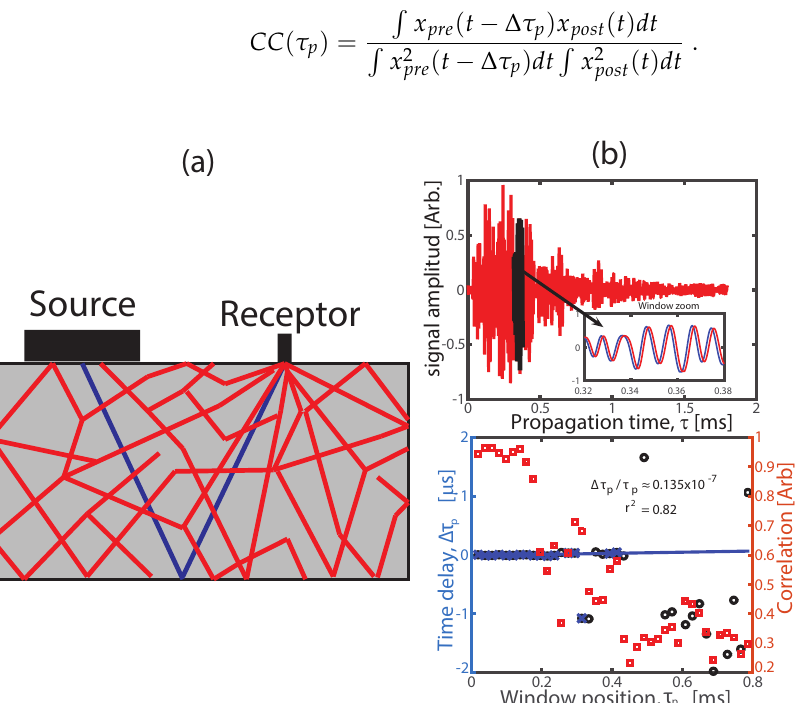
Figure 2. CWI technique. ( a ) Schematic diagram showing the principle of the CWI technique with a coda wave source and a small receptor. The coherent pulse is shown in blue while the diffuse waves are shown in red. ( b ) Sound speed estimation by fitting the filtered curve ∆ τ p against τ p (blue). In Figure 2b above, two consecutive coda signals are shown and in the inset it is highlighted the time-shift of a specific window (black). In Figure 2b below it is shown the ∆ τ p against τ p (blue and black) and CC ( τ p ) (red), which is used as a filter to select the good estimates